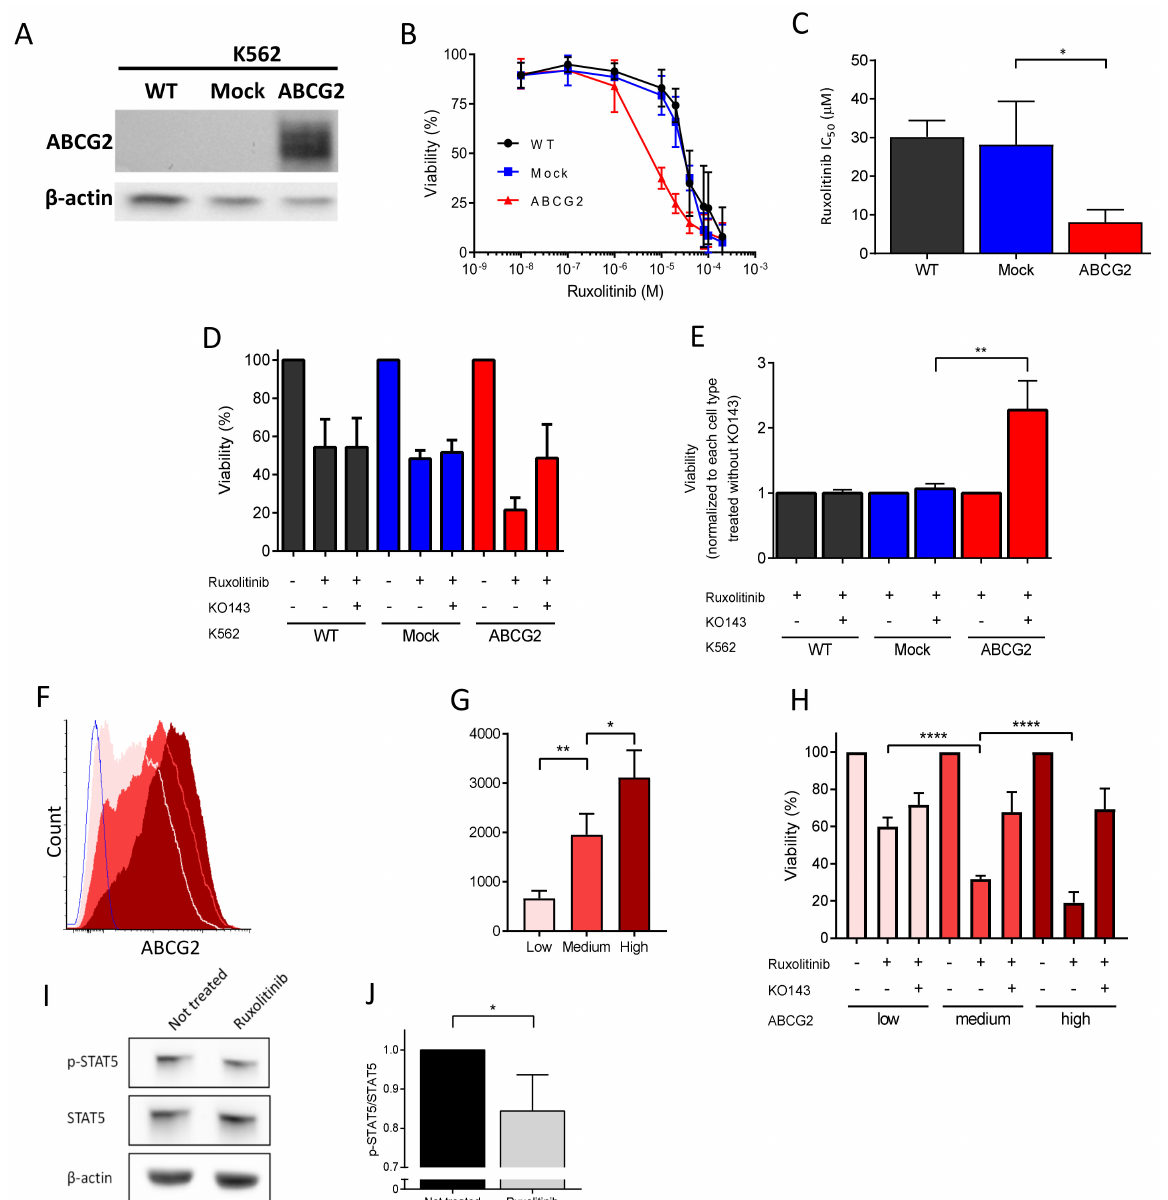
Figure 4. Ruxolitinib-induced apoptosis in K562 ABCG2 cells is dependent on the ABCG2 expression level and is reduced by ABCG2 inhibition. ( A ) SDS-PAGE immunoblots of ABCG2 expression on K562 WT, mock, and ABCG2-transfected cells. Beta-actin served as the loading control. ( B ) Ruxolitinib-induced cytotoxicity of K562 WT- (black), mock- (blue), and ABCG2- transfected cells (red). Cell viability was measured by CCK8 72 h after 0–200 µ M ruxolitinib treatment. ( C ) Ruxolitinib IC